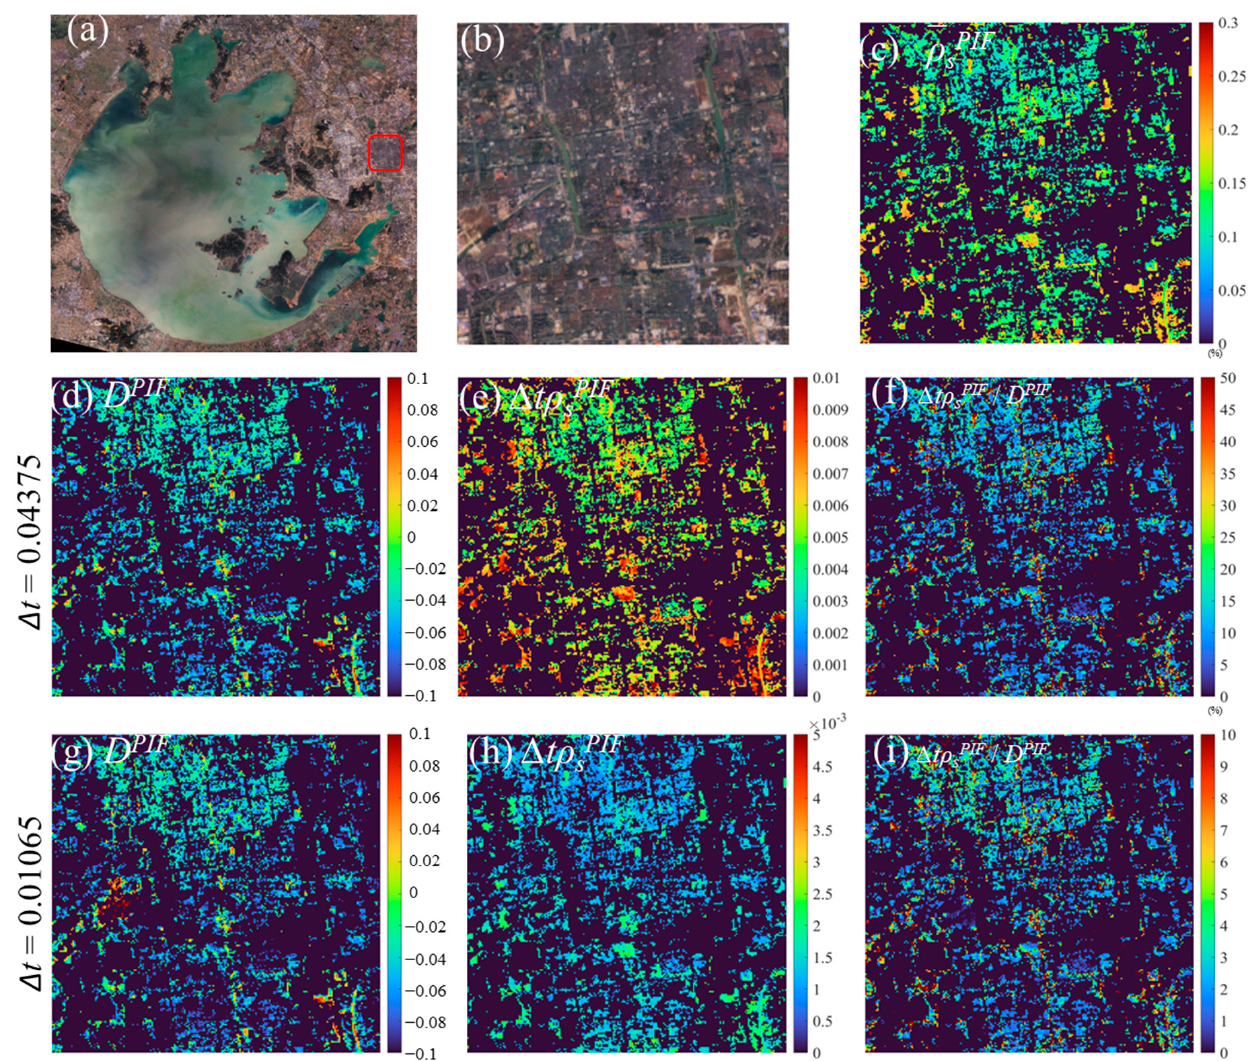
Figure 14. Variations in the transmi tt ance ( t ) in SWIR bands (based on cloudless images from 2013 to 2018, a total of 36 images).